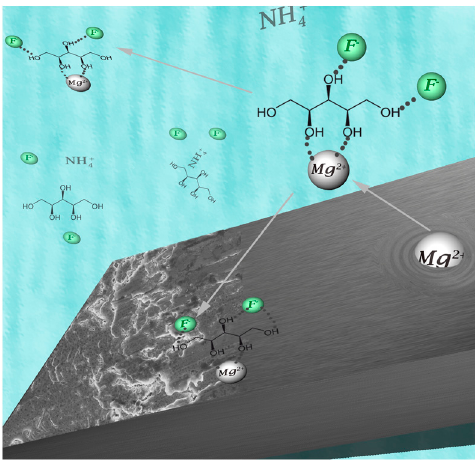
Figure 8. Possible formation of Mg 2+ -based complexes with Xy-F in both the electrolyte and at the anode surface, which could cause issues with the battery performance.